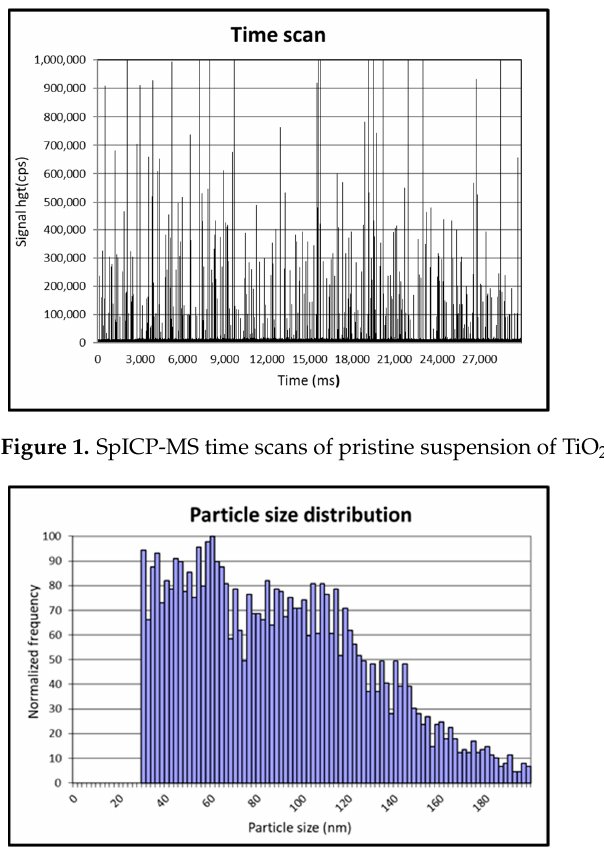
Table 1. Mass-based concentrations and particle sizes of TiO 2 NPs detected by spICP-MS in mussels after in vivo exposure to different treatments (with controls).